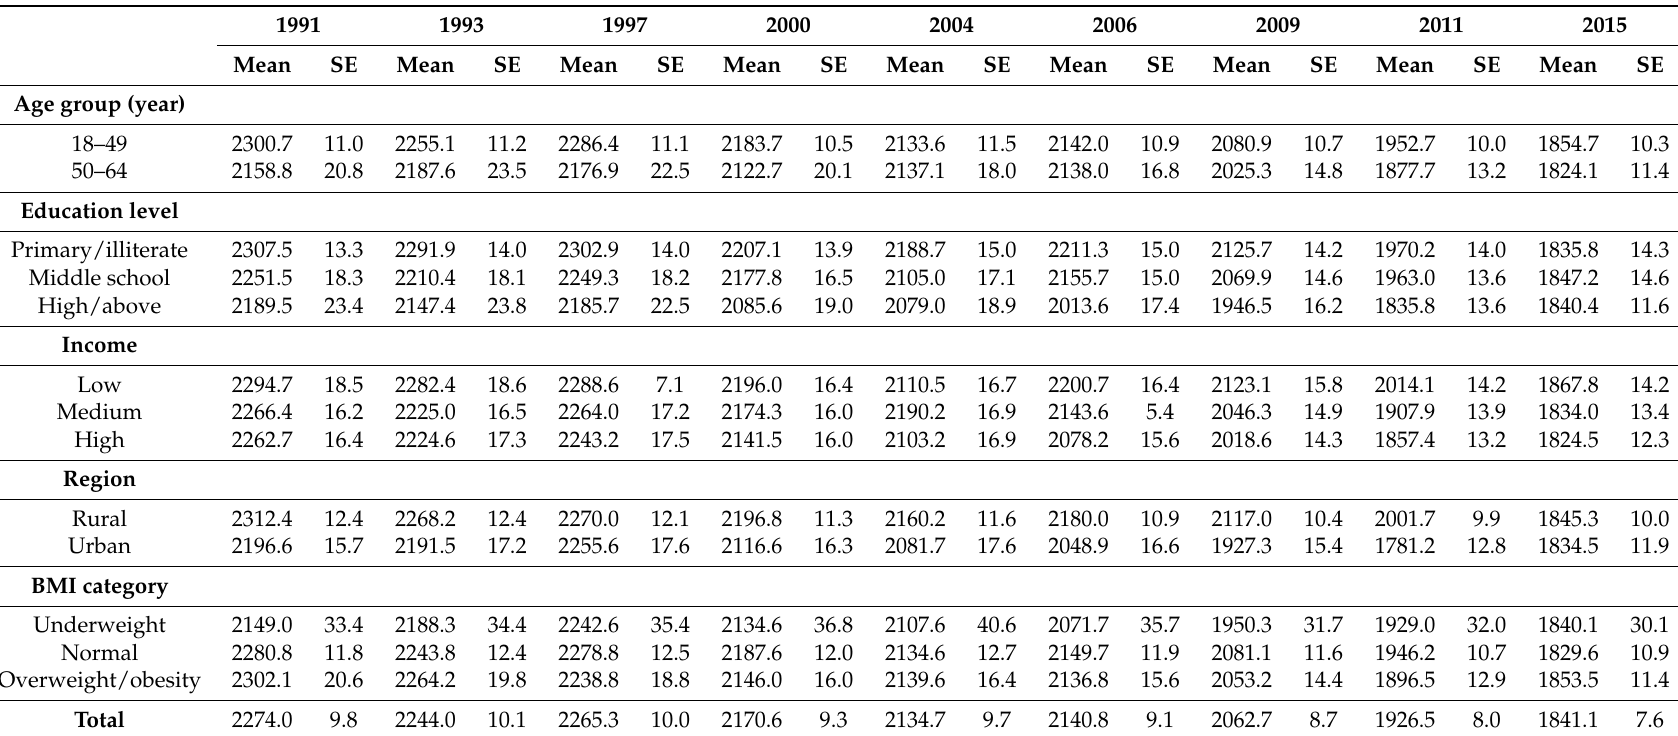
Table 2. Daily energy intake (kcal), by age, education, income and geographical region in Chinese women from 1991 to 2015 1, 2